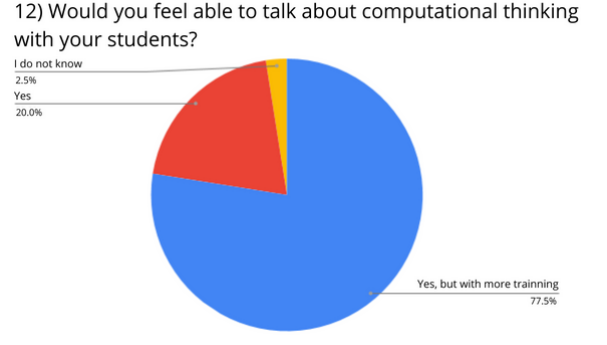
Figure 2 . Graph of the Database workshop's responses to the question “Would you feel able to talk about computational thinking with your students?”.